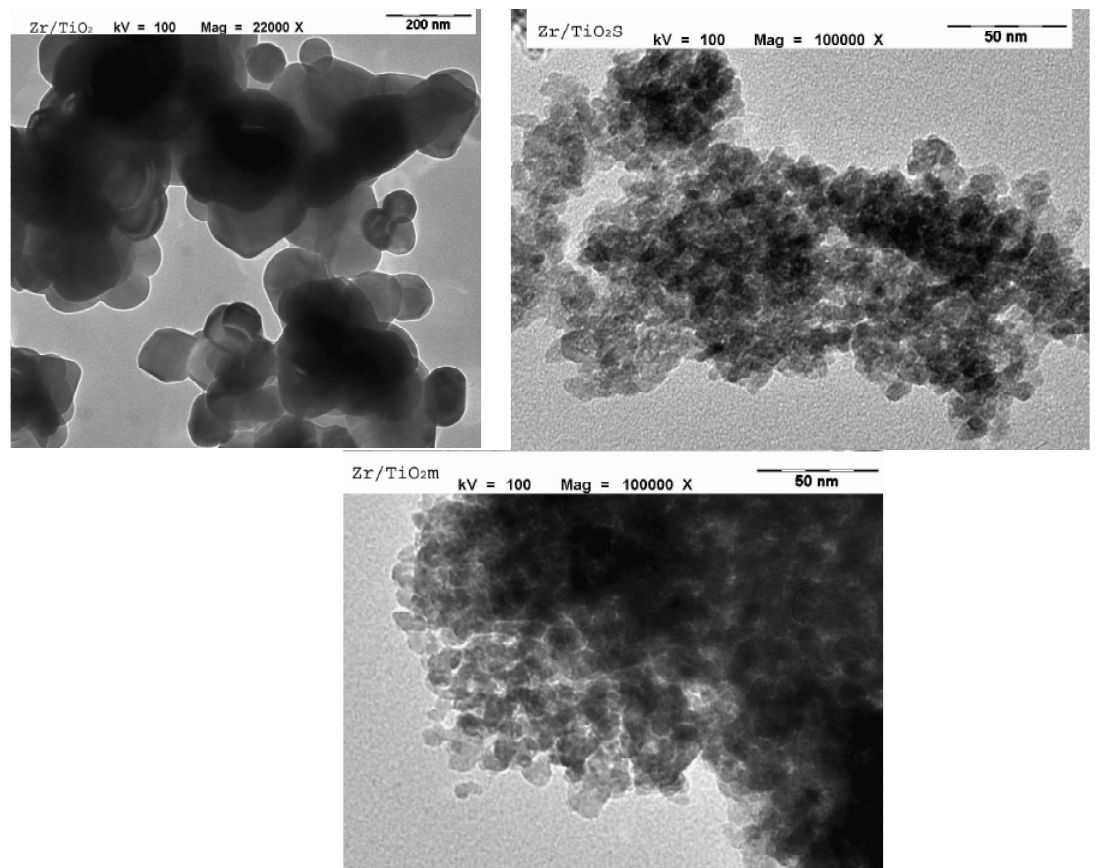
Figure 3. TEM photographs of doped titania samples